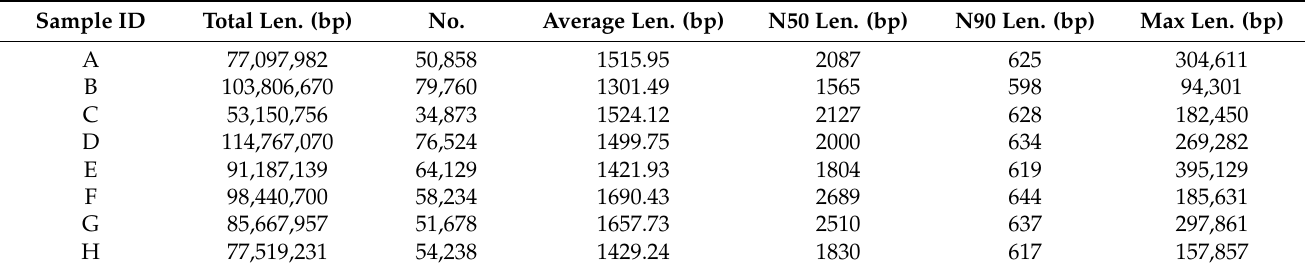
Table 2. The assembly results of each sample. Scaftig information ( ≥ 500 bp).